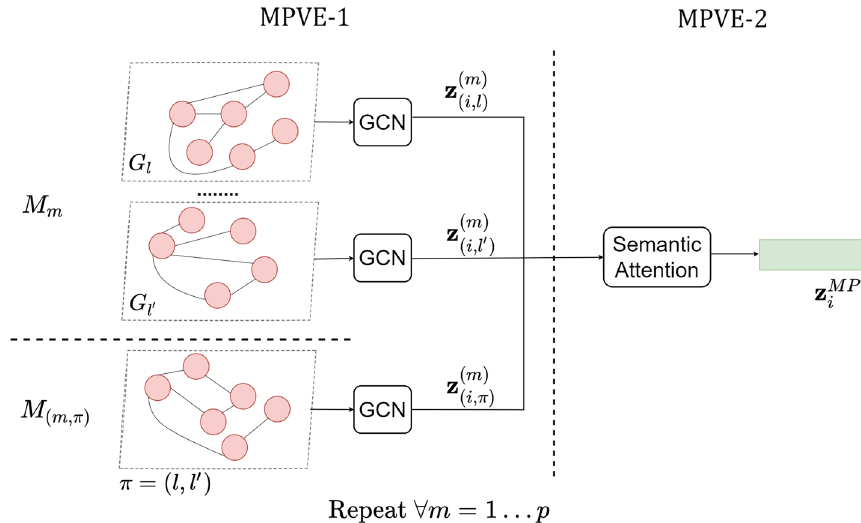
Fig. 6 Illustration of the sub-steps of the Co-MLHAN embedding generation under the meta-path view of the entity v